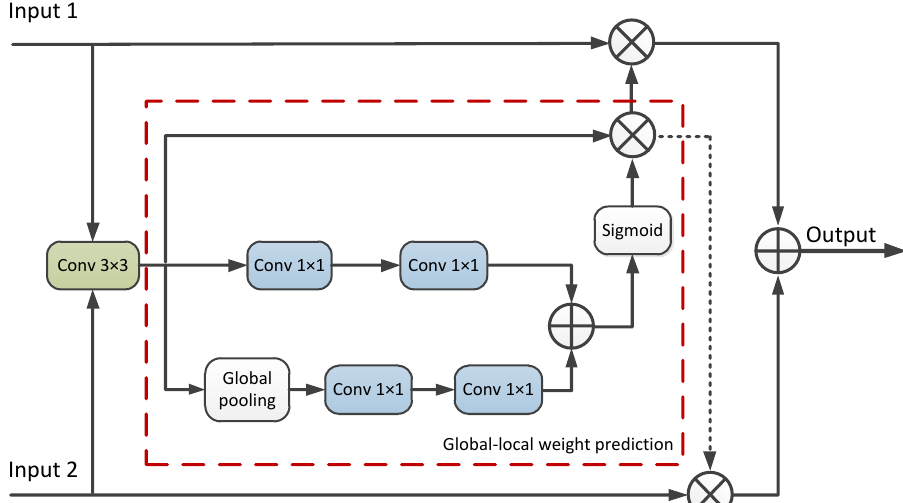
Figure 4. Illustration of the attention-based feature